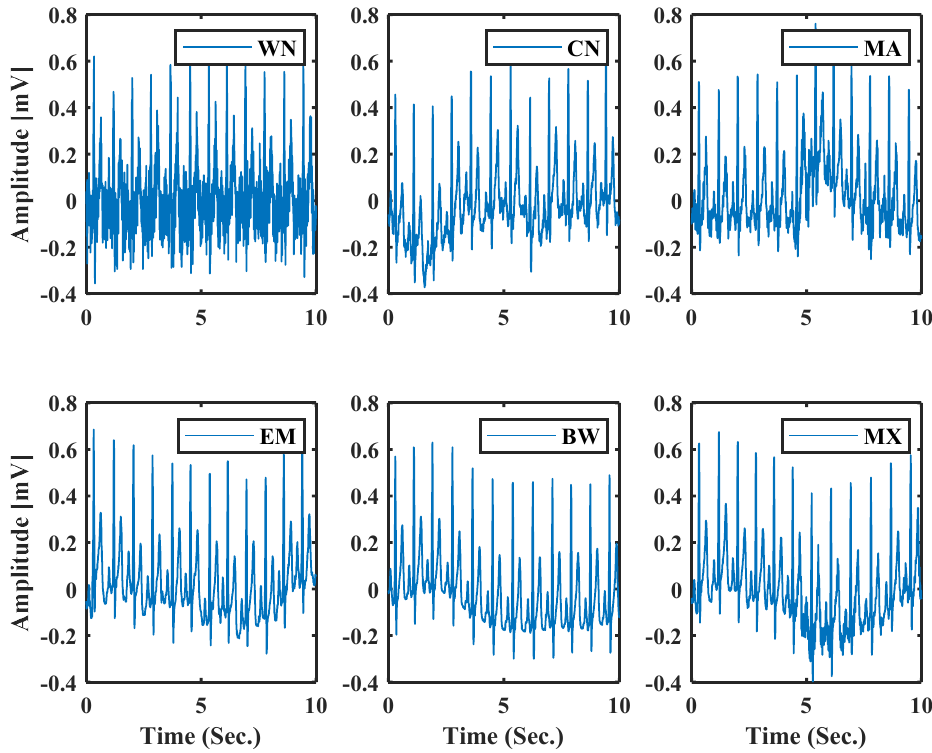
Figure 11. Normal ECG with different types of noise using the model parameters. (6) Wavelet Analysis: The wavelet analysis is also be performed by using this GUI. (7) Sampling frequency: There are four different sampling frequencies which the user